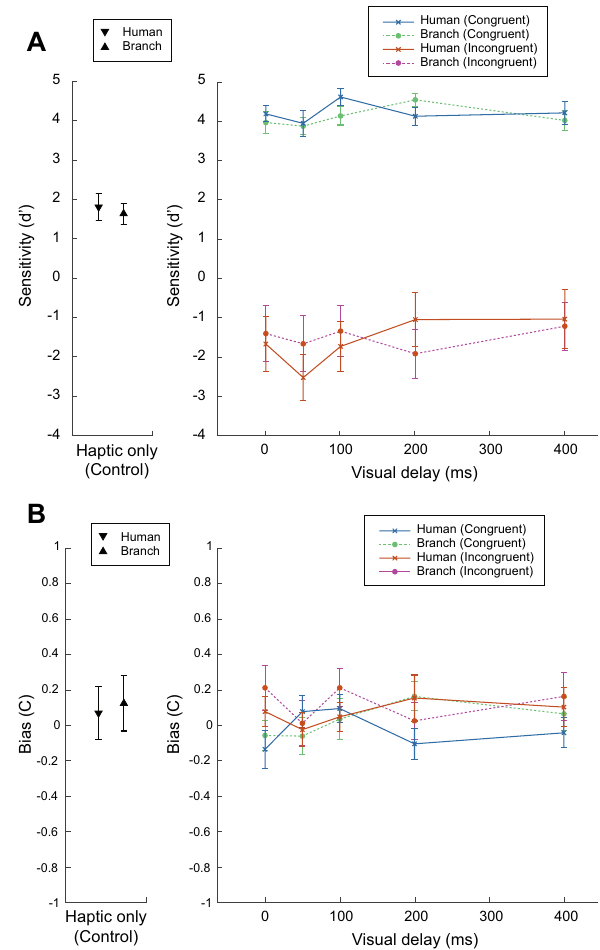
Figure 1. Mean ( A ) sensitivity (d ′ ) and ( B ) response bias (C) of direction